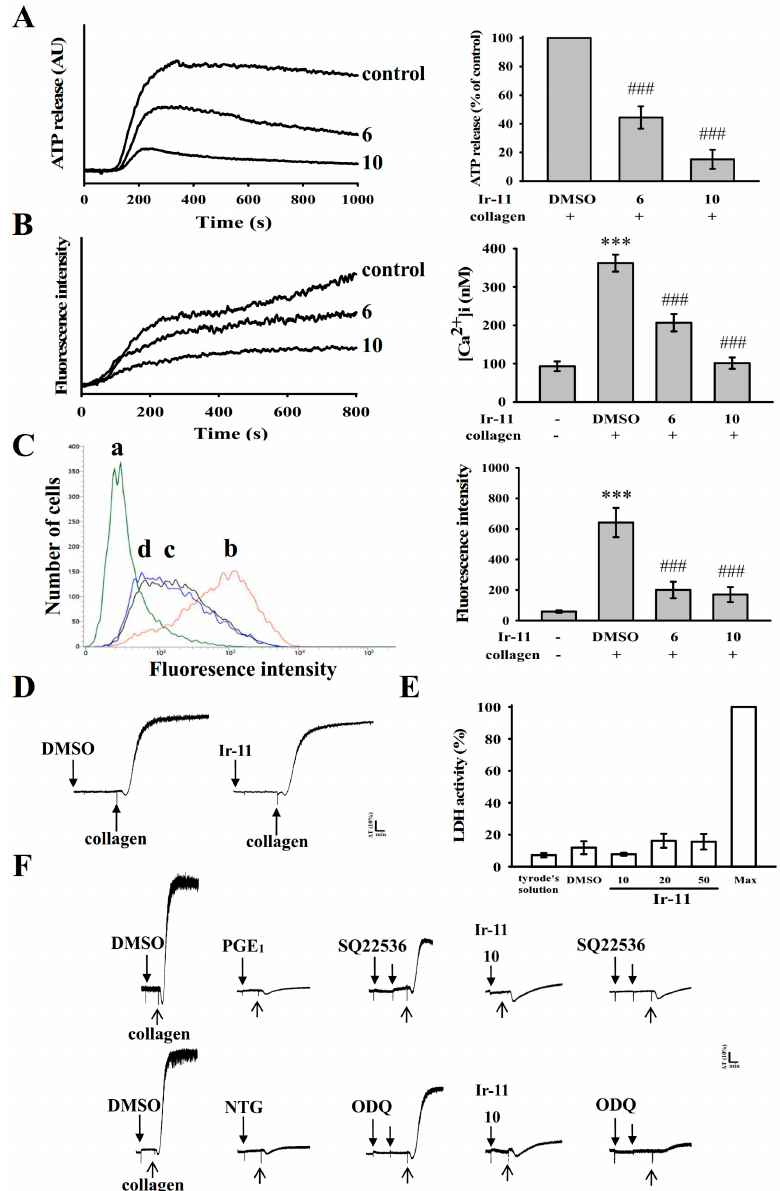
Figure 3. Effect of Ir-11 on ATP release, relative [Ca 2+ ]i mobilization, surface P-selectin expression, cytotoxicity, LDH release, and cyclic nucleotide formation in human platelets. Washed platelets (3.6 × 10 8 cells/mL) were preincubated with the solvent control (0.1% DMSO), Ir-11 (6 and 10 µM), or fluorescein isothiocyanate (FITC)–P-selectin (2 µg/mL), and collagen (1 µg/mL) was then added to trigger either ( A ) ATP release (AU; arbitrary unit), ( B ) relative [Ca 2+ ]i mobilization, or ( C ) surface P-selectin expression (a) Tyrode’s solution (resting control), (b) 0.1% DMSO, (c) 6 µM Ir-11, or (d) 10 µM Ir-11. The corresponding statistical data are shown in the right panel of each figure ( A – C ); ( D ) Washed platelets were preincubated with the solvent control (0.1% DMSO) or Ir-11 (50 µM) for 10 min and subsequently washed two times with Tyrode solution; collagen (1 µg/mL) was then added to trigger platelet aggregation; ( E ) Washed platelets were preincubated with the solvent control (0.1% DMSO) or Ir-11 (10, 20, and 50 µM) for 20 min, and a 10 µL aliquot of the supernatant was deposited on a Fuji Dri-Chem slide LDH-PIII; ( F ) For other experiments, washed platelets were preincubated with PGE 1 (1 µ M), NTG (10 µ M), or Ir-11 (10 µM) with or without SQ22536 (100 µM) or ODQ (10 µM), and were subsequently treated with collagen (1 µg/mL) to induce platelet aggregation. Data are presented as means ± standard error of the means ( n = 4). Profiles in ( D , F ) are representative of four independent experiments. *** p < 0.001 compared with the resting control; ### p < 0.001, compared with the DMSO-treated group.